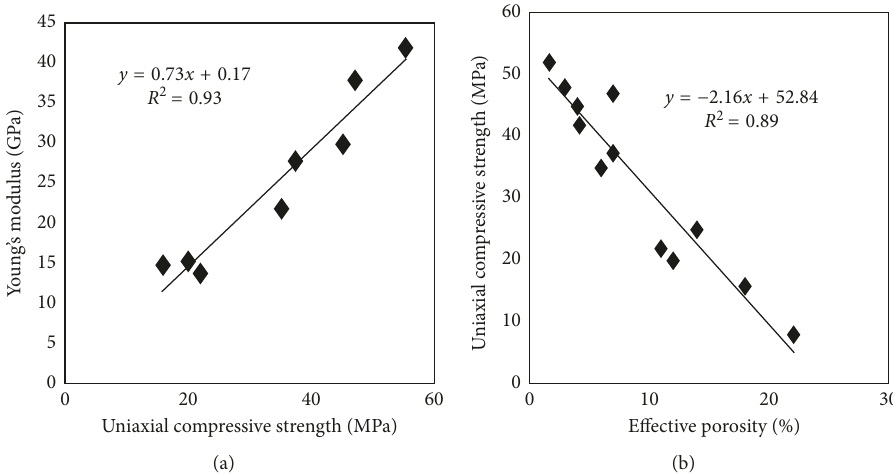
Figure 2: Linear relationship and correlation coefficient between petrophysical and geomechanical properties of cores samples from wells in the Krishna-Godavari basin. (a) Young’s modulus and uniaxial compressive strength. (b) Uniaxial compressive strength and effective porosity.